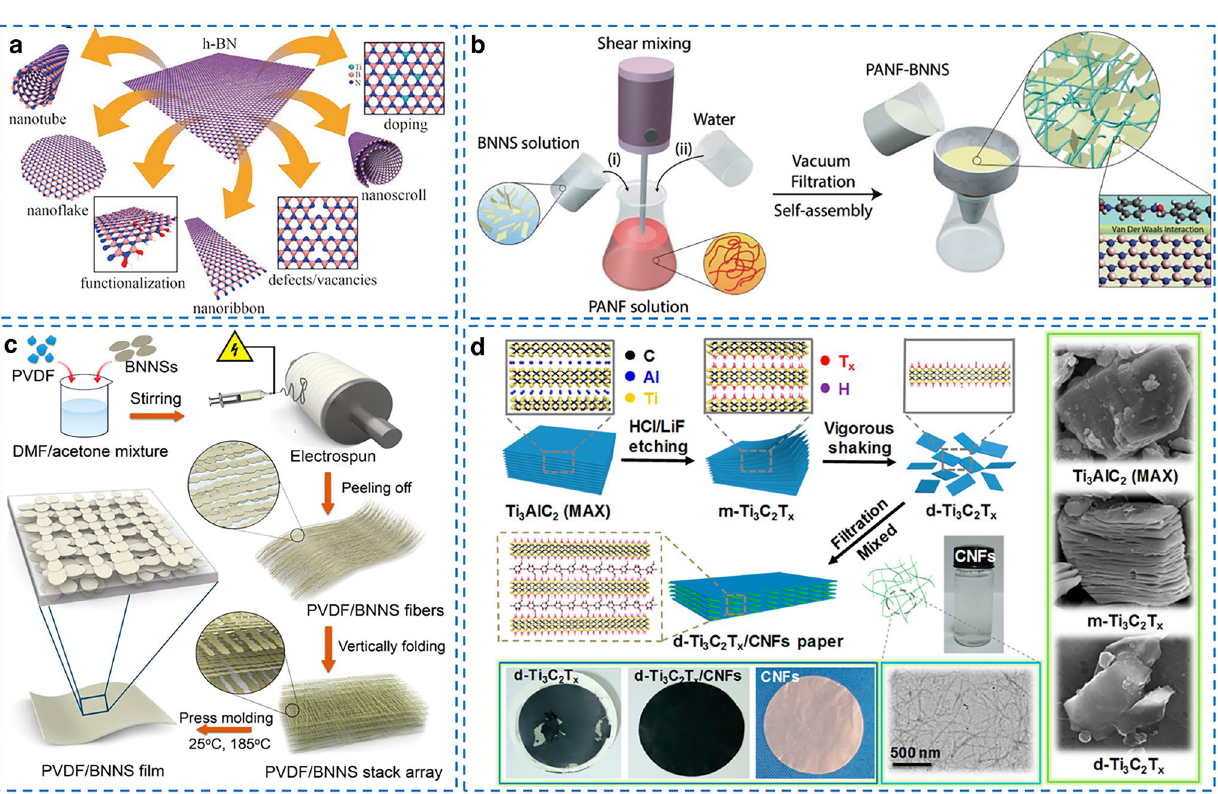
Fig. 9 Fabrication of thermally conductive ceramic/polymer composite films with high in‑plane k . a Possible configurations derived from BN. Reproduced with permission from Ref. [134]. Copyright 2021, Wiley–VCH. b Preparation process of the BNNS/PI nanofibers films using vac‑ uum filtration method. Reproduced with permission from Ref. [138]. Copyright 2019, Wiley–VCH. c Preparation process of the BNNS/ PVDF films using electrospinning method. Reproduced with permission from Ref. [139]. Copyright 2019, American Chemical Society. d Preparation process of the MXene/NFC films using vacuum filtration method. Reproduced with permission from Ref. [140]. Copyright 2018, American Chemical